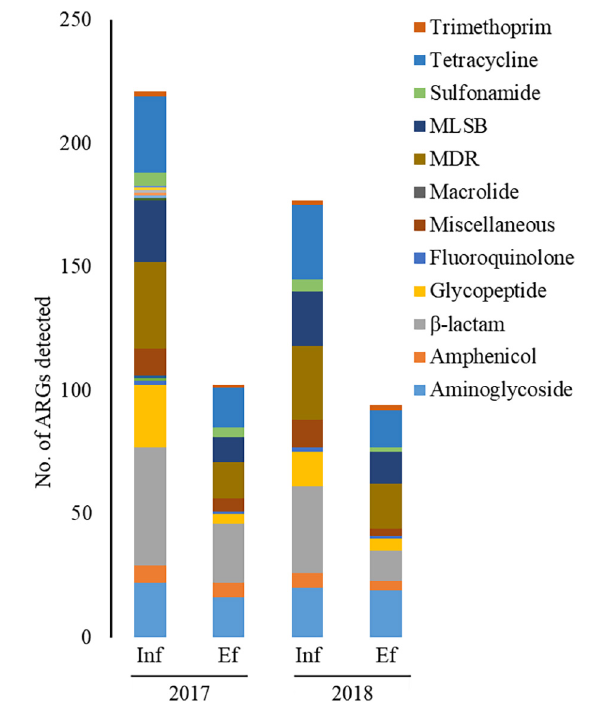
FIGURE 2 | The relative abundance of antibiotic resistance genes (ARGs) from the influent (Inf) and the effluent (Ef) of wastewater treatment plants through SmartChip analyses. The copy number of ARGs was normalized by that of 16S rDNA, and it represented the relative abundance of ARGs. Each color indicates the classes of ARGs. An asterisk ( ∗ ) denotes a statistically significant difference (Wilcox test; p < 0.05) between influents and effluents of the WWTP.